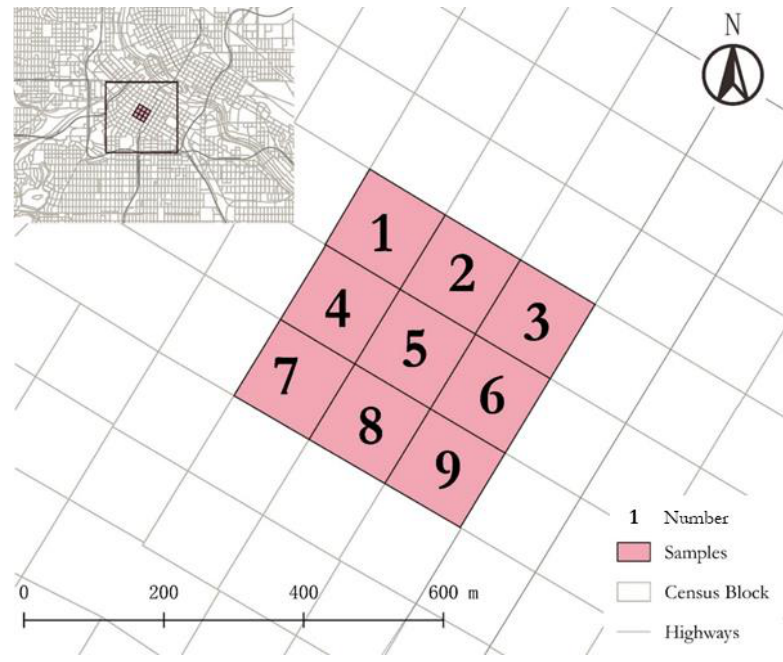
Figure 2. Sample blocks for constructing spatial weight matrices.